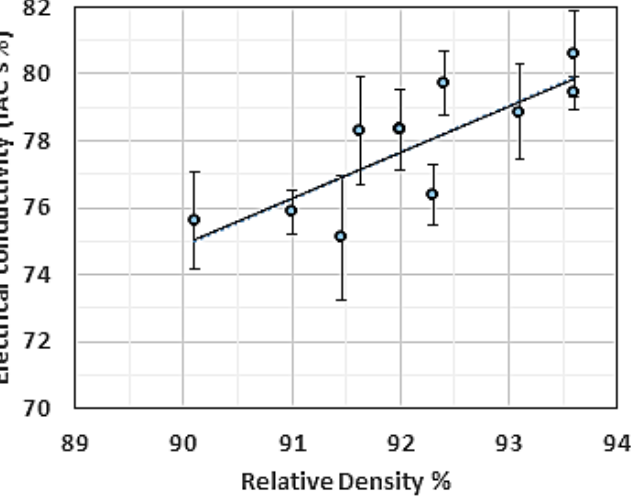
Figure 21. Electrical conductivity (EC) vs. relative density (RD) for the 2 mm Cu coils fabricated by L-PBF.